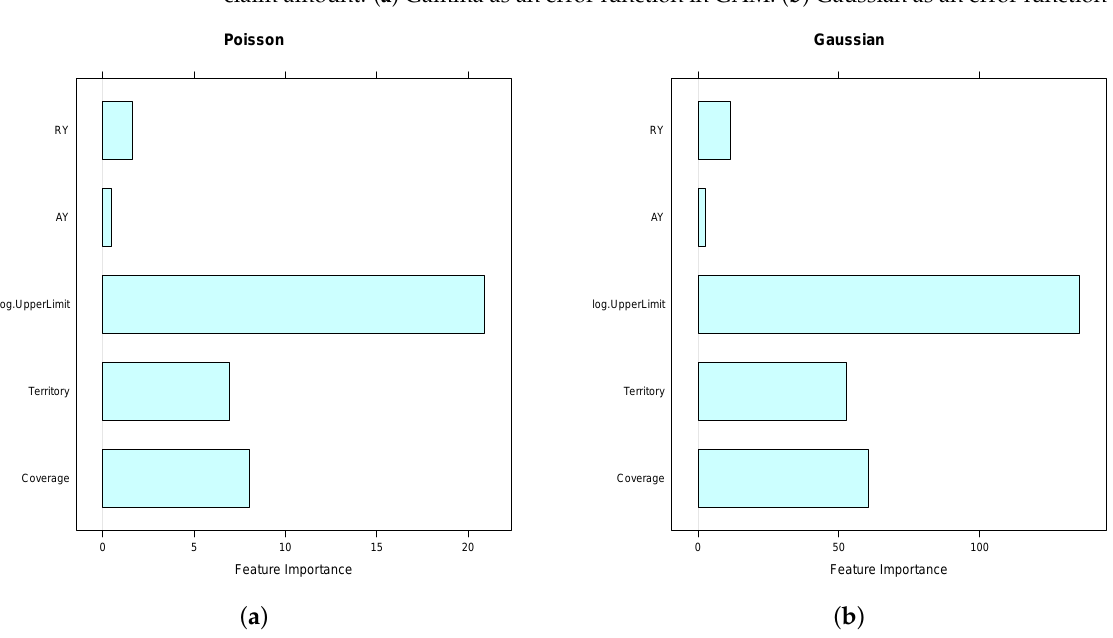
Figure 7. Bar plots for variable importance measures of risk factor in GAM based on the log scale claim counts. (The Poisson error function is with log link function). ( a ) Poisson as an error function in GAM. ( b ) Gaussian as an error function in